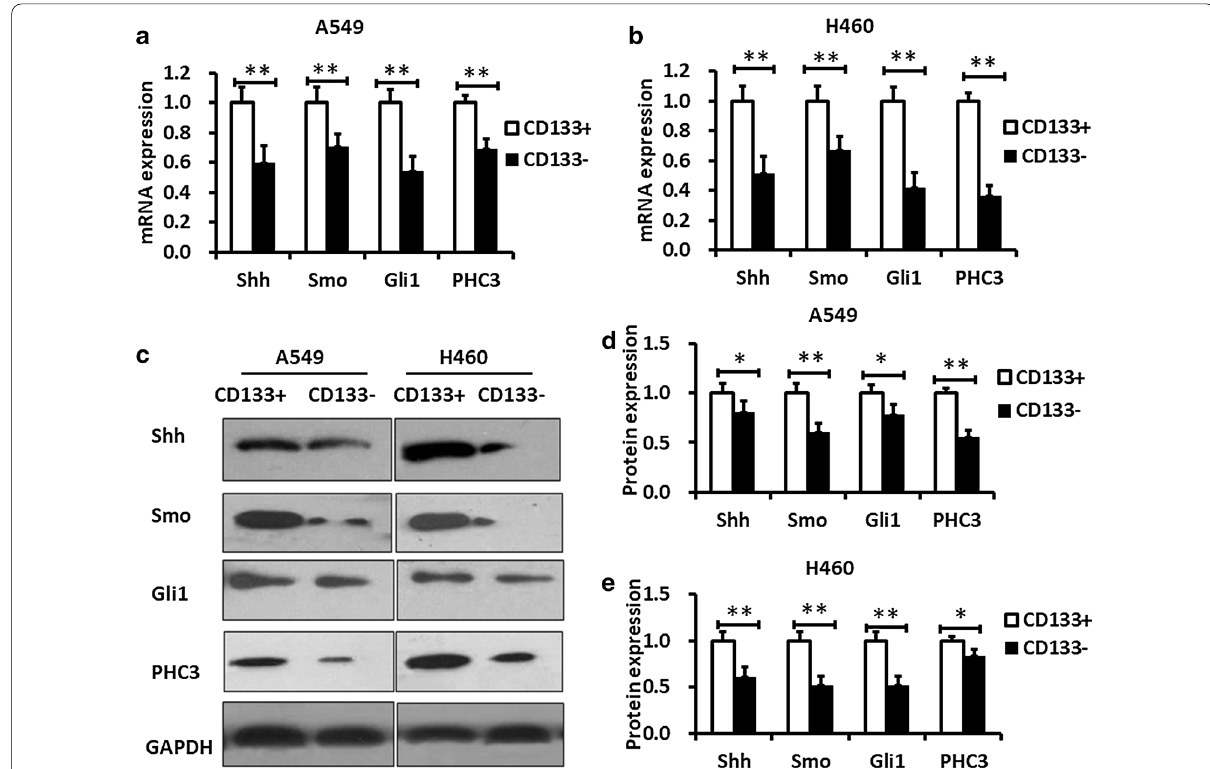
Fig. 2 Expression of Shh, Gli1, Smo and PHC3 in CD133 + and in CD133 − lung cancer cells. a , b QPCR data shows that the mRNA levels of Shh, Gli1, Smo and PHC3 in A549/CD133 + and H460/CD133 + are higher than those in A549/CD133 − and H460/CD133 − . c – e Western blotting data shows that the protein levels of Shh, Gli1, Smo and PHC3 in A549/CD133 + and H460/CD133 + cells are higher than those in A549/CD133 − and H460/CD133 − cells. The relative protein levels were quantified with Image J software. N ***P <